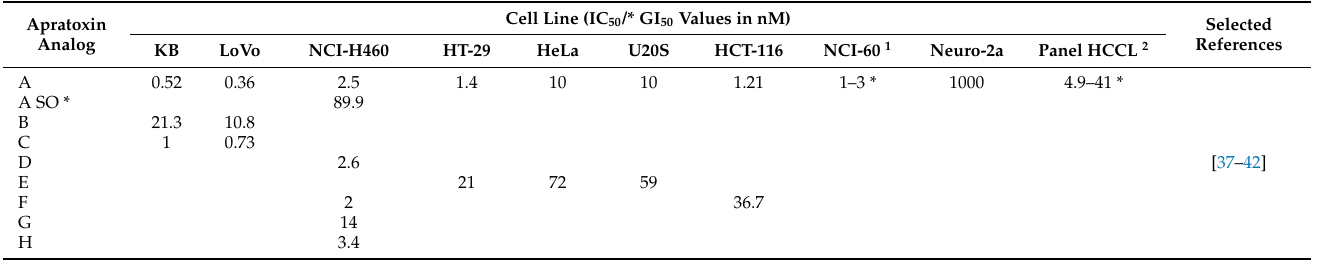
Table 4. Apratoxin analog activities on cancer cell